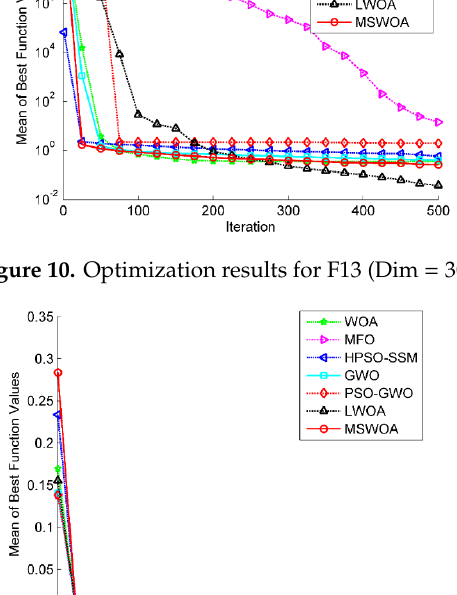
Figure 12. Optimization results for F18 (Dim = 6).